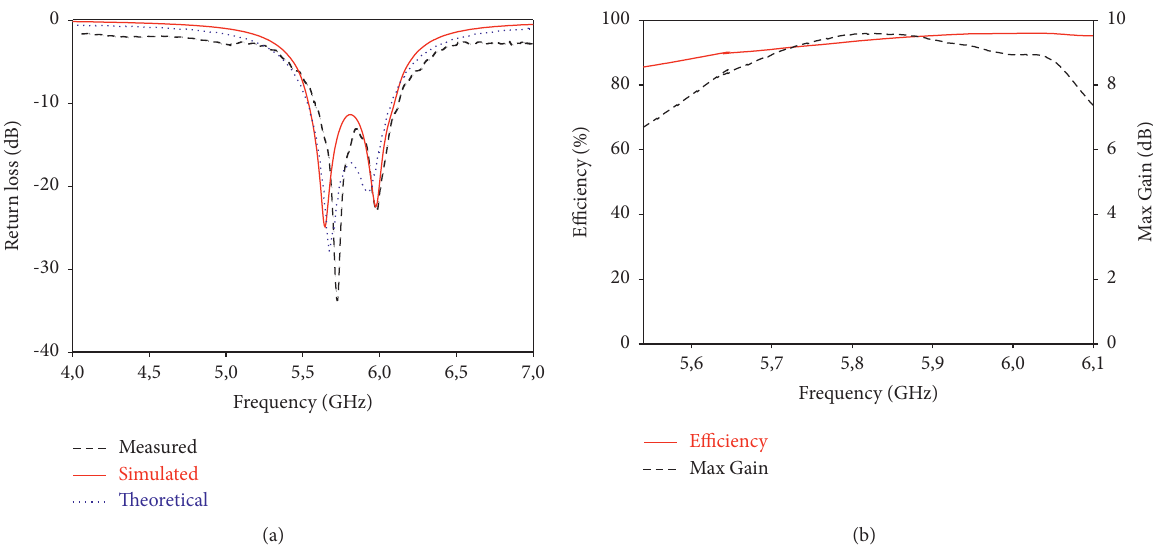
Figure 10: (a) Simulated, theoretical, and measured S11 and (b) simulated antenna efficiency and gain.